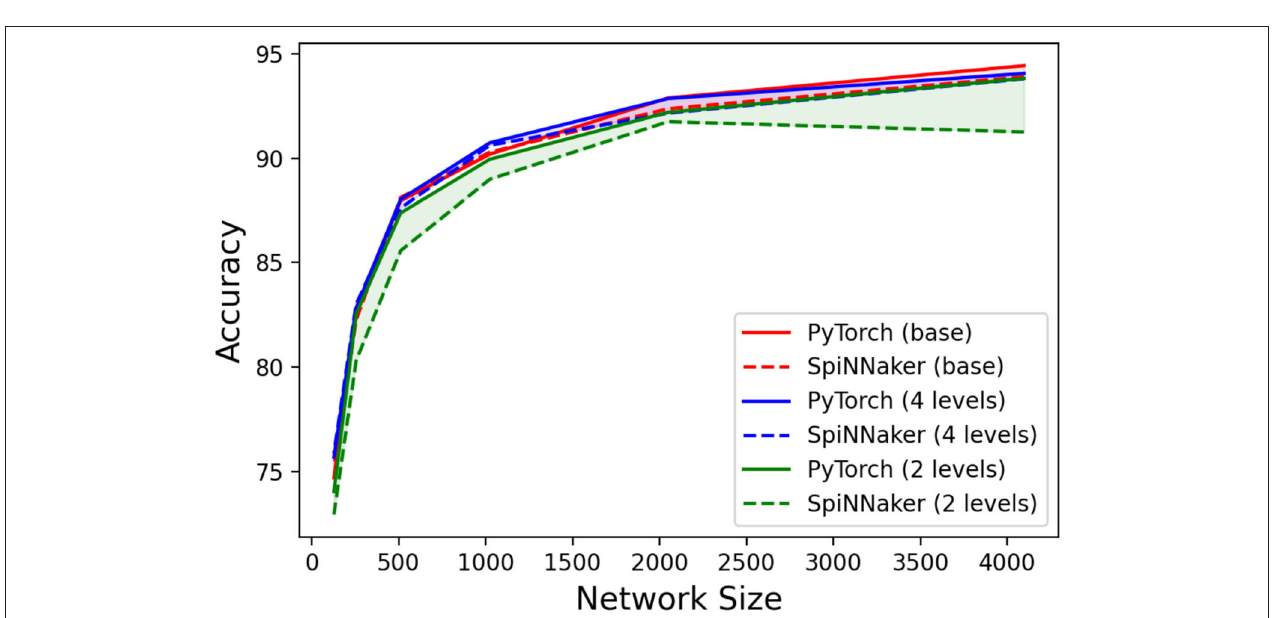
Frontiers in Neuroscience |